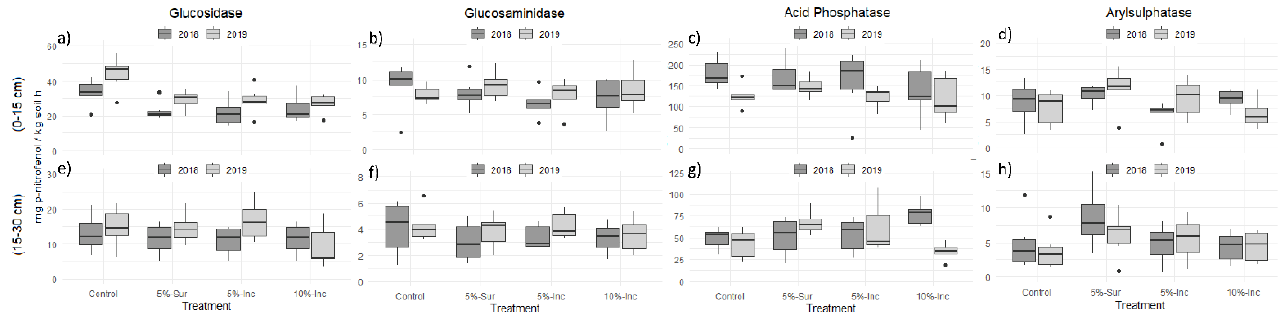
Figure 2. Enzyme activities with and without biochar addition. Error bars represent standard error of the means (n = 6); Inc-incorporated; Sur-surface.